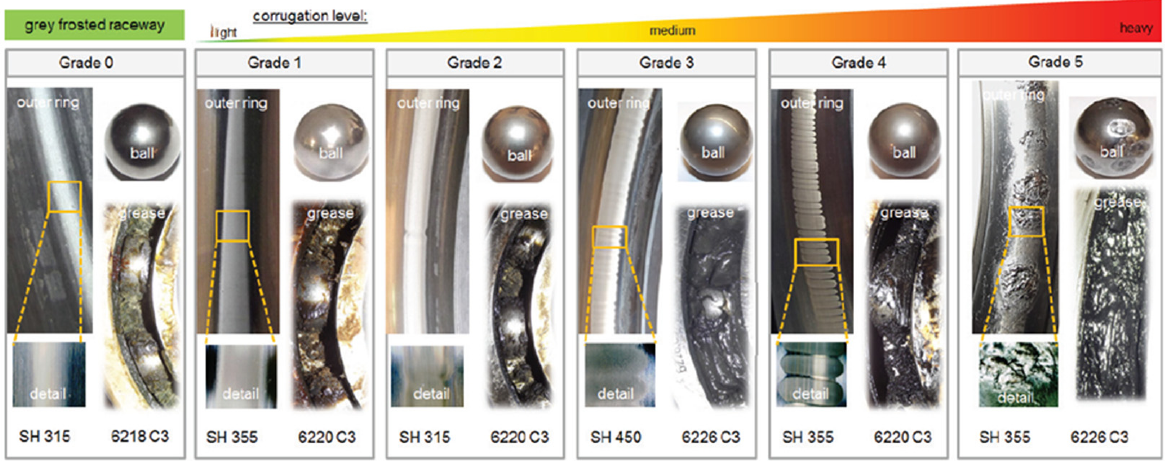
Figure 1. Different grades of bearing damages. ©2018 IEEE. Reprinted, with permission, from [17]. While the scale seems to be suitable for a qualitative and comparative description of the electric bearing damages, these disadvantages make this scale unsuitable for a quantitative description of the bearing damage. Several authors use different approaches to quantify the surface properties of electrically damaged bearing surfaces [18–23]. The shown results are measurements of standardized one- or two-dimensional surface properties, described by DIN ISO 4287 or ISO 25178-2 [24,25]. This surface properties are by design metrical scales suitable for quantitative descriptions of surfaces and independent of the evaluating person. Since each of the aforementioned publication uses different surface properties,